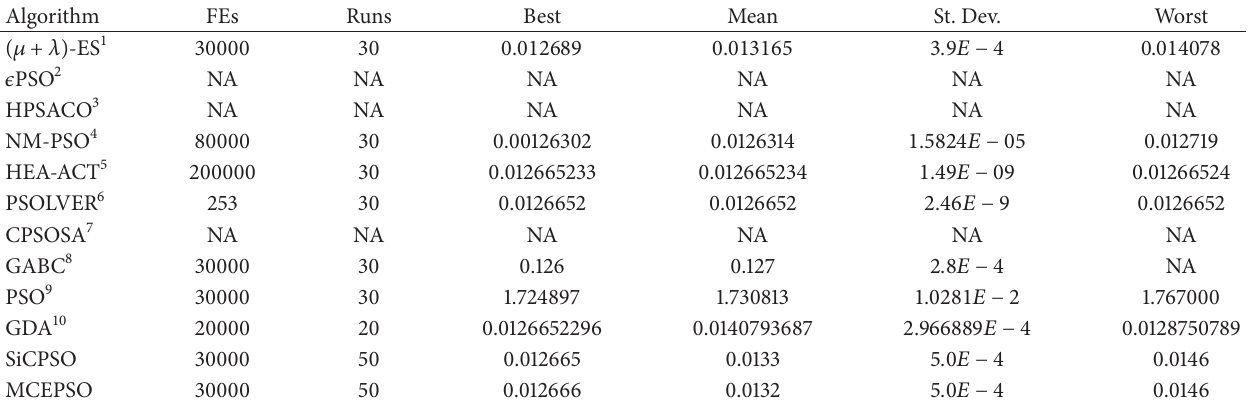
Table 6: Results for E04: tension/compression spring design.